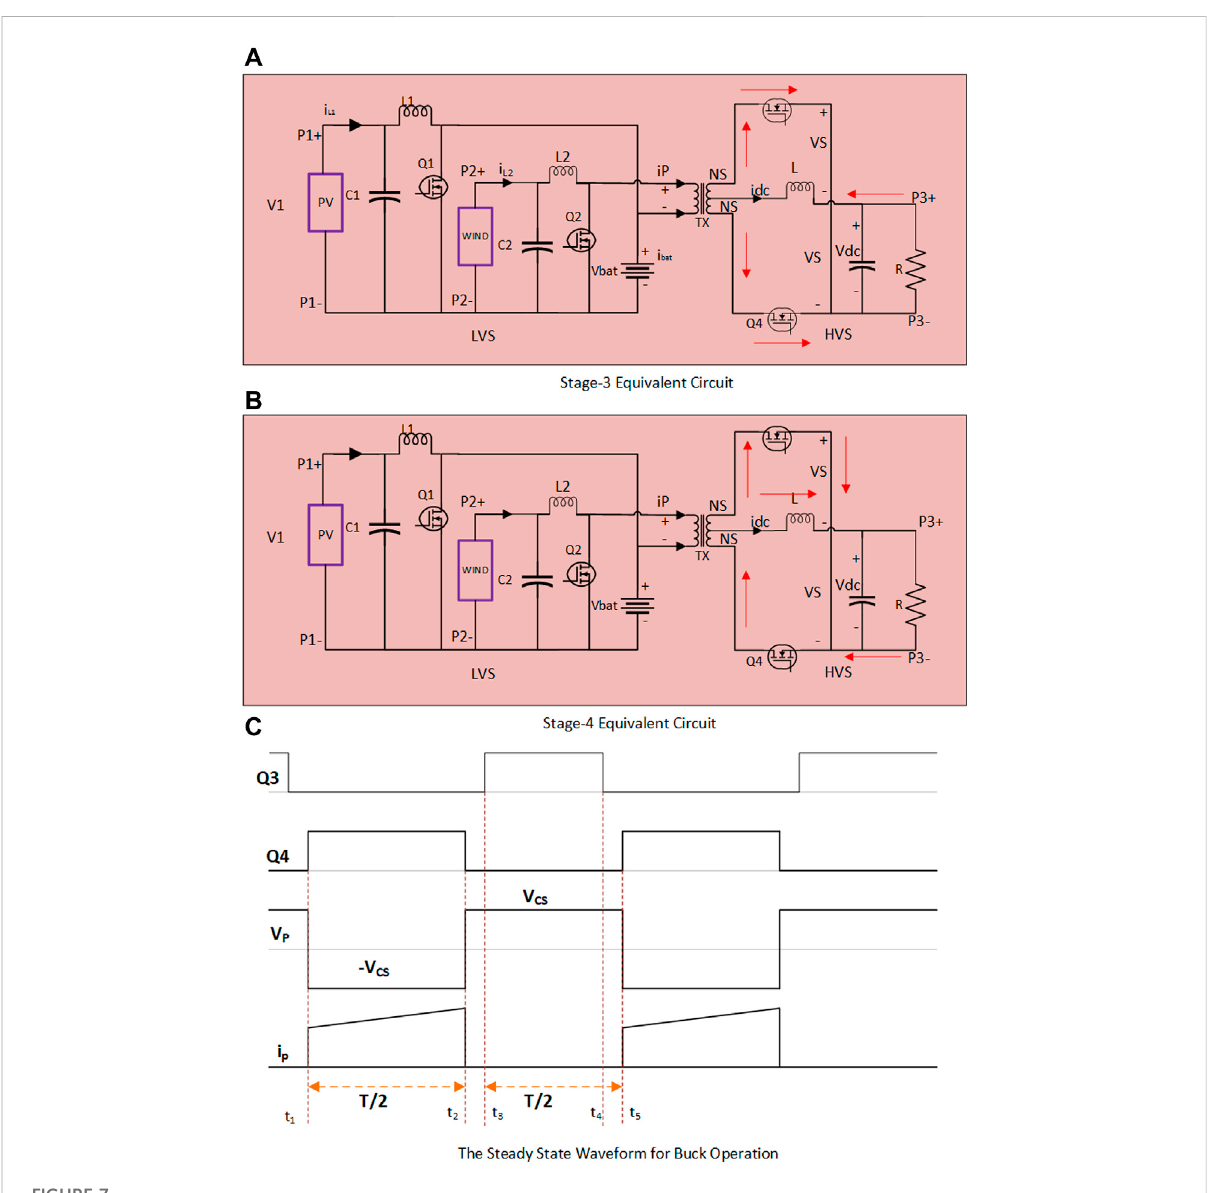
FIGURE 7 The proposed converter ’ s study in buck mode in stage 3 and 4 without